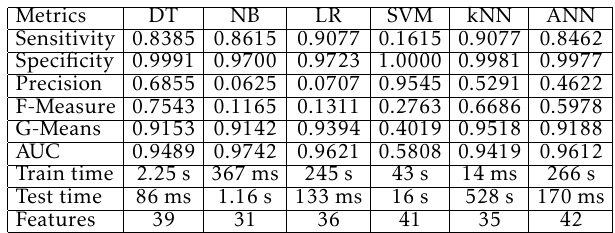
Table 5. Results of using CA-BFE algorithm on WORMS.